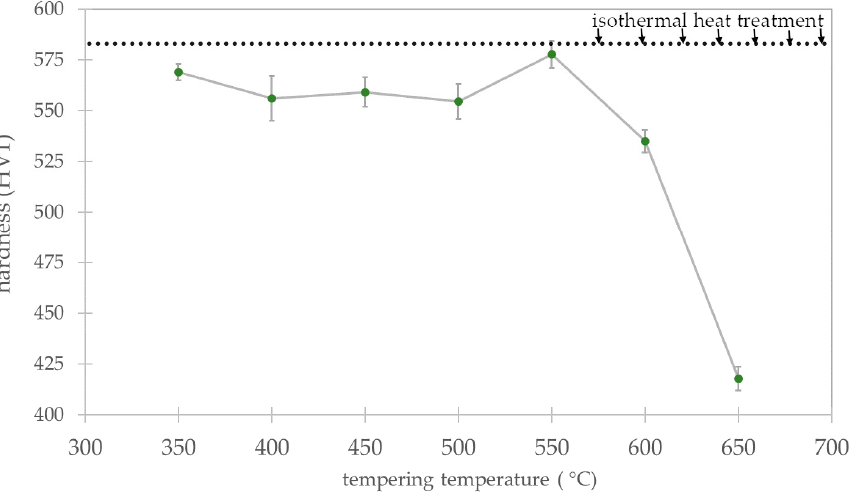
Figure 13. Hardness distribution of experimental steel after isothermal heat treatment at 280 °C subjected to the tempering process.